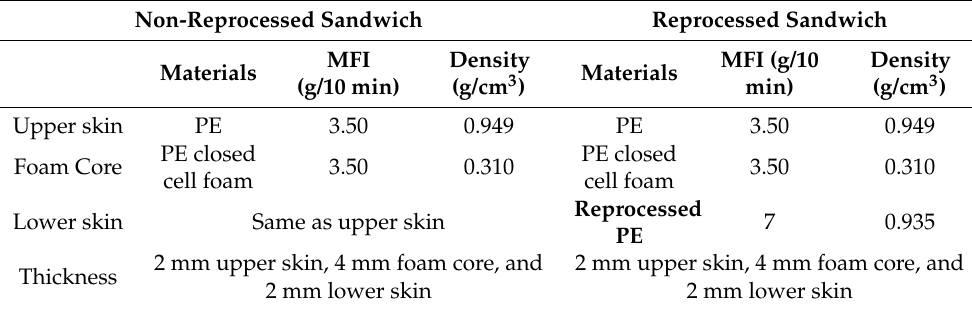
Table 1. Materials and sandwich structure details 1